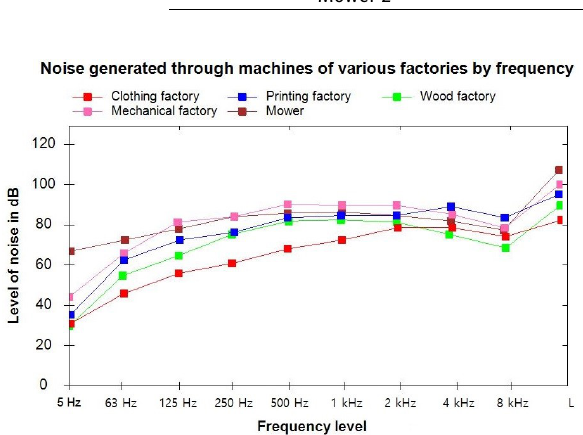
Figure 4: Level of noise from machines of various factories at differ- ent frequency